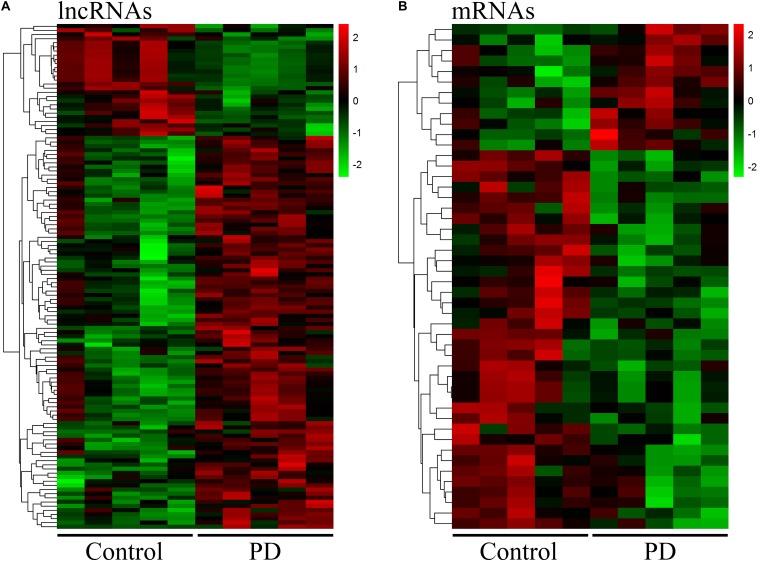
Distinct expression profile of lncRNA and mRNA in circulating leukocytes between PD and healthy controls. The heat map and hierarchical clustering of all differentially expressed lncRNAs (A) and mRNAs (B) (FC ≥ 2.0) in circulating leukocytes between PD and healthy controls. Each row represents one lncRNA or mRNA and each column represents one subject. The relative expression levels of lncRNA or mRNA are represented by color. Red color denotes high expression levels while green color denotes low expression levels. The numbers in the color scale represent fold changes. n = 5 for PD patients, and n = 5 for healthy controls. Two-tailed unpaired Student’s t-test, p < 0.05.